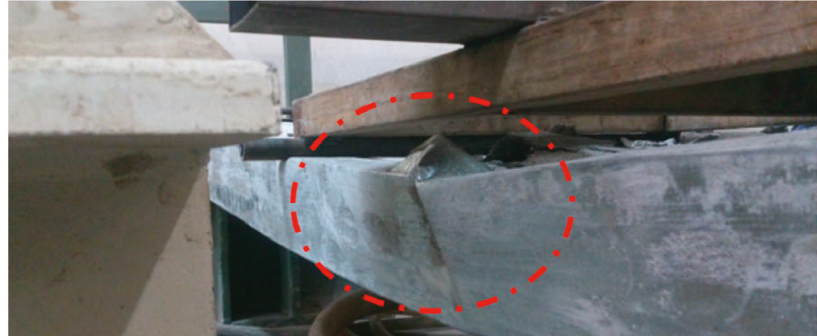
Figure 13: Cracks progress on the top of the panel in step 2.